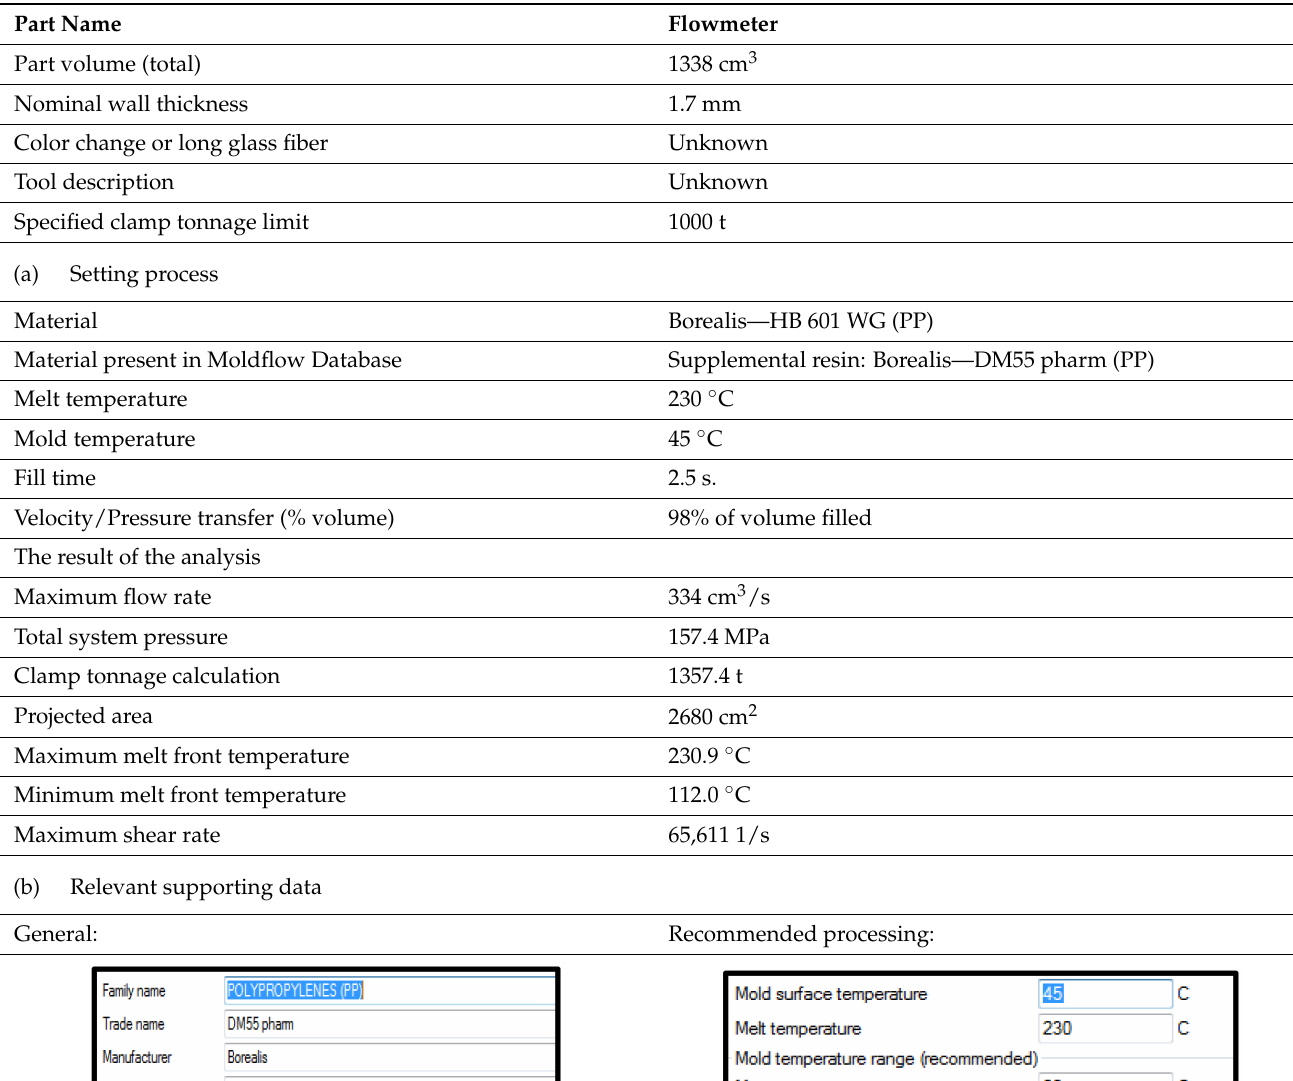
Table 2. A detailed description of the